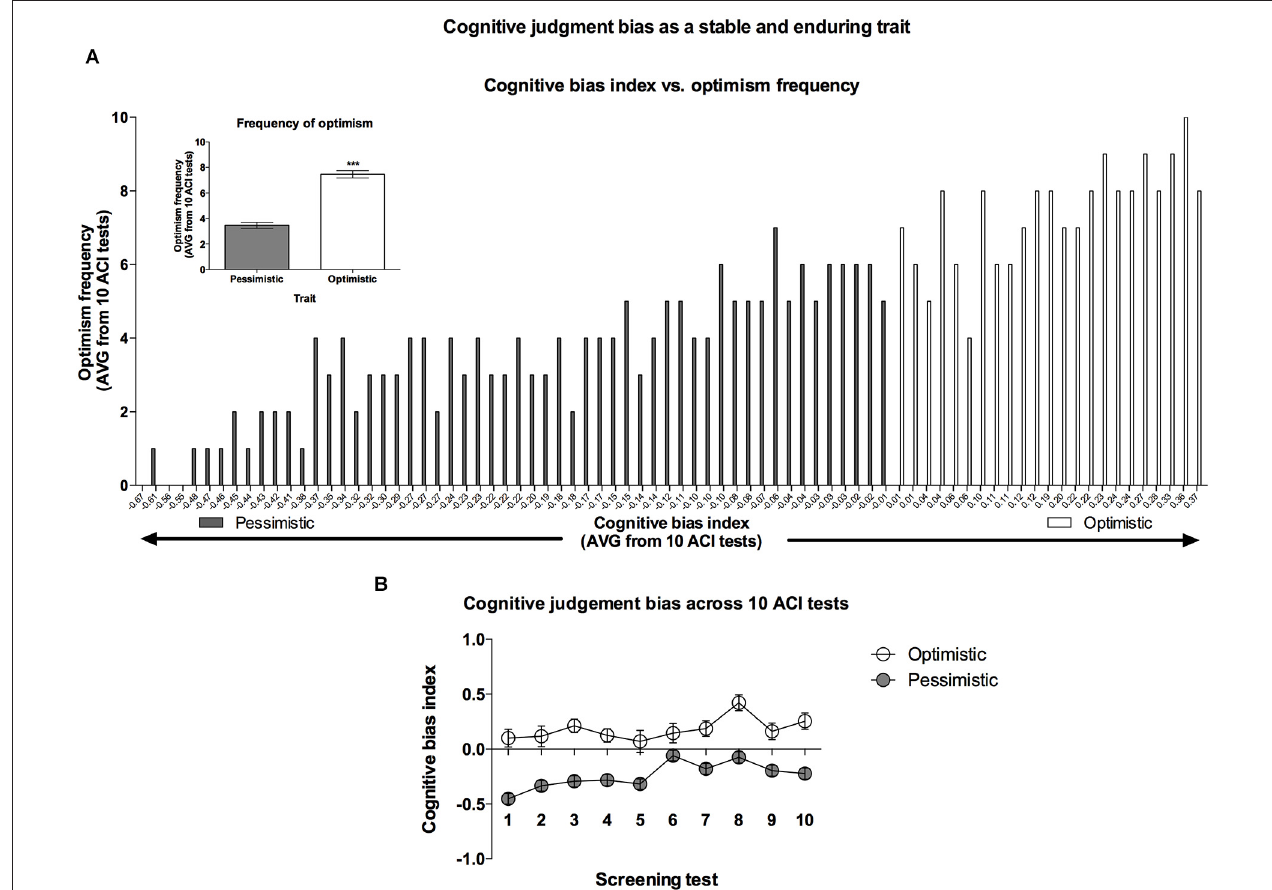
The mean ± SEM “optimism” frequency of the animals classified (based on 10 ACI tests) as “optimistic” (open bar, N = 24) and “pessimistic” (filled bar, N = 56). (B) The mean ± SEM cognitive bias index of the animals classified as “optimistic” (open circles, N = 24) and “pessimistic” (filled circles, N = 56) across all 10 baseline ACI